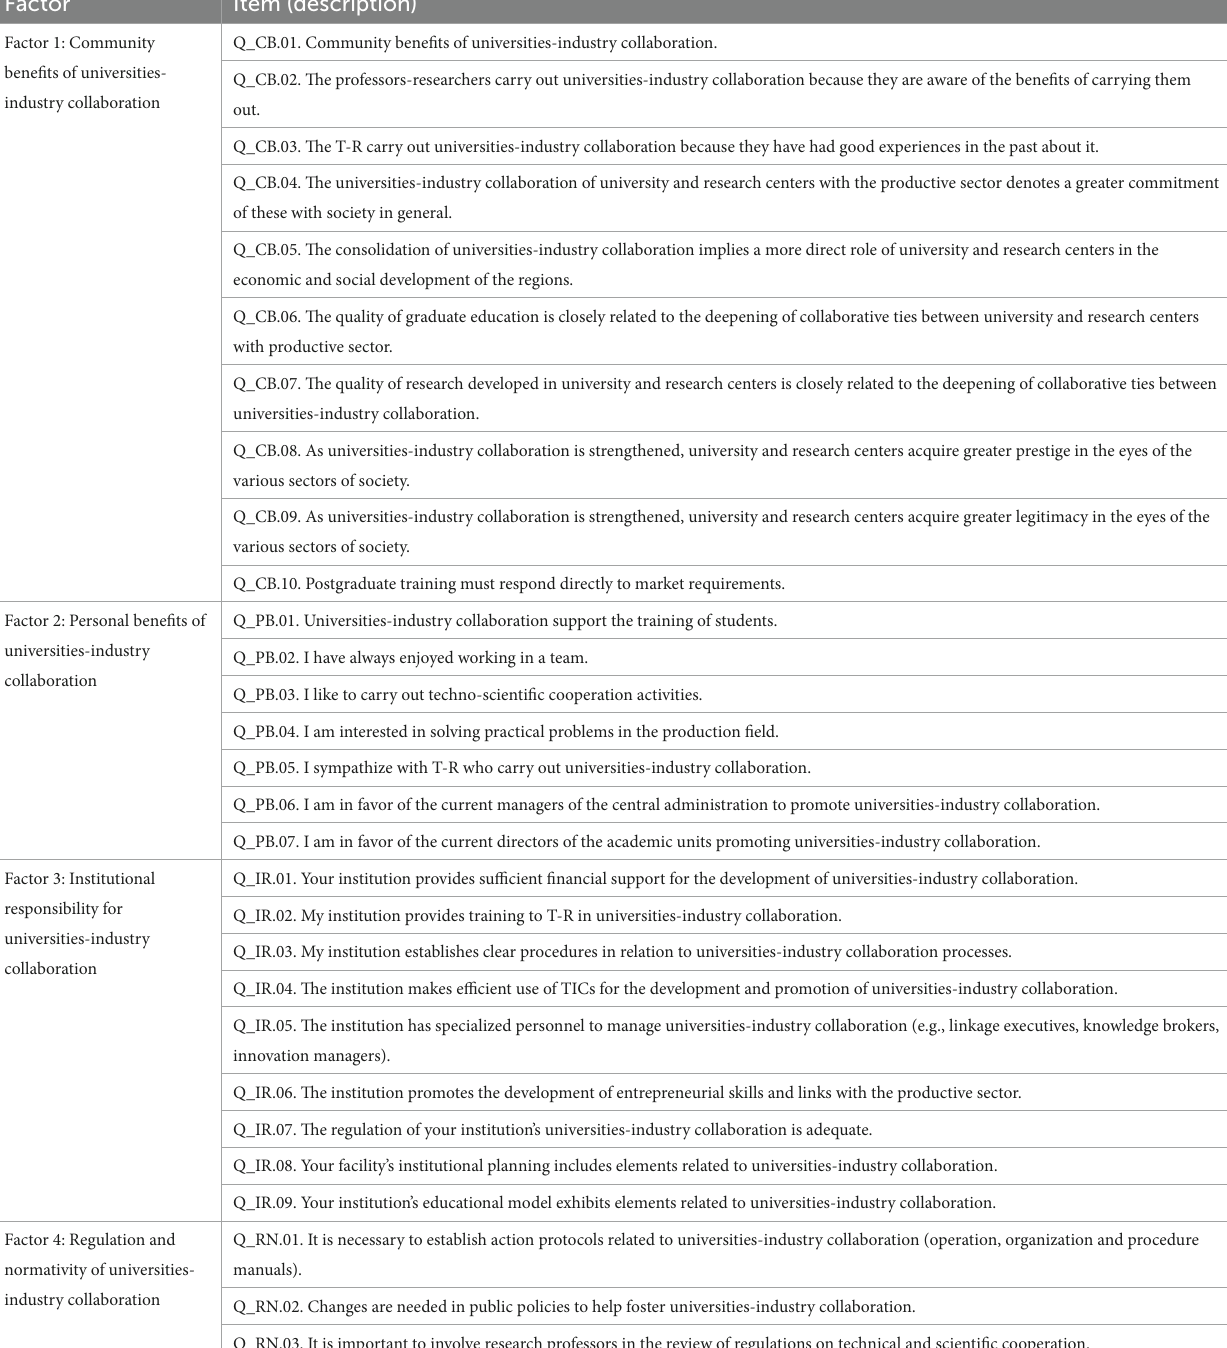
TABLE 4 Distribution of the items of the EA-COOPTEC v0.1 by four factors